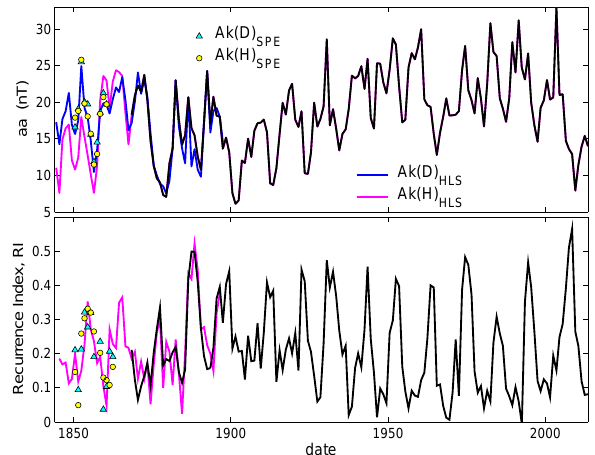
Fig. 4. (Top) The zero-lag correlation r of annual mean geomag- netic indices with BV n , as a function of the exponent n , for the Fig. 5. The extension of the aa index back to 1845 using Helsinki SW corrected aa index, aa C (blue), the IHV index (mauve), the IDV(1d) data. (Upper panel) The corrected aa index, aa C . (Lower panel) index (cyan) and the IDV index (black). All data are for the period Sargent’s recurrence index from daily values of aa C , RI. In both 1966–2012, inclusive. Peak correlation is marked by the vertical panels annual means are shown: the black lines are for the cor- dashed line of the same colour. (Middle) The significance, S , of the rected index, aa C , the blue and mauve lines are for, respectively, difference between the peak correlation and that at general n from the Ak ( D) HLS and Ak ( H) HLS indices derived for Helsinki data by the Fisher Z test. (Bottom) The probability that correlations for two Nevanlinna (2004) and the points shown by yellow circles and cyan different indices have the same n , (1- S 1 ) (1- S 2 ) , as a function of n triangles are from the Ak ( D) SPE and Ak ( H) SPE indices for St Pe- where S 1 and S 2 are the S values for the two geomagnetic indices: tersburg data derived by Nevanlinna and Häkkinen for IDV(1d) and aa C (black); IDV and aa C (red); IDV and IHV (orange); and IDV(1d) and IHV (green). The n and r of peak corre- lations are given in Table 1.